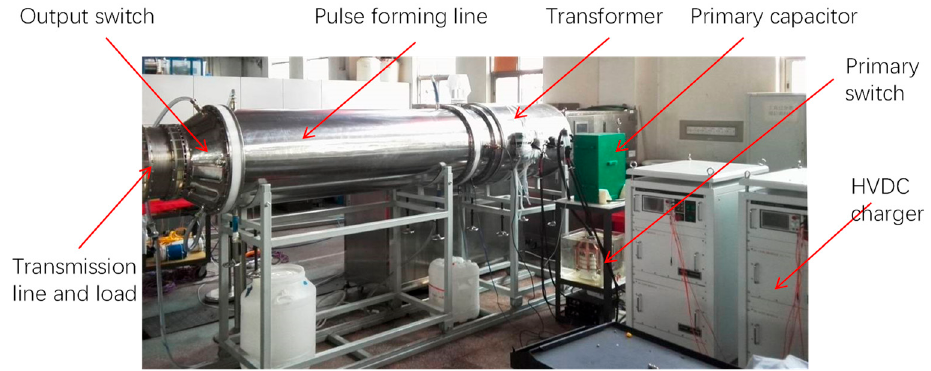
Figure 2. Photo of the HPM driver.